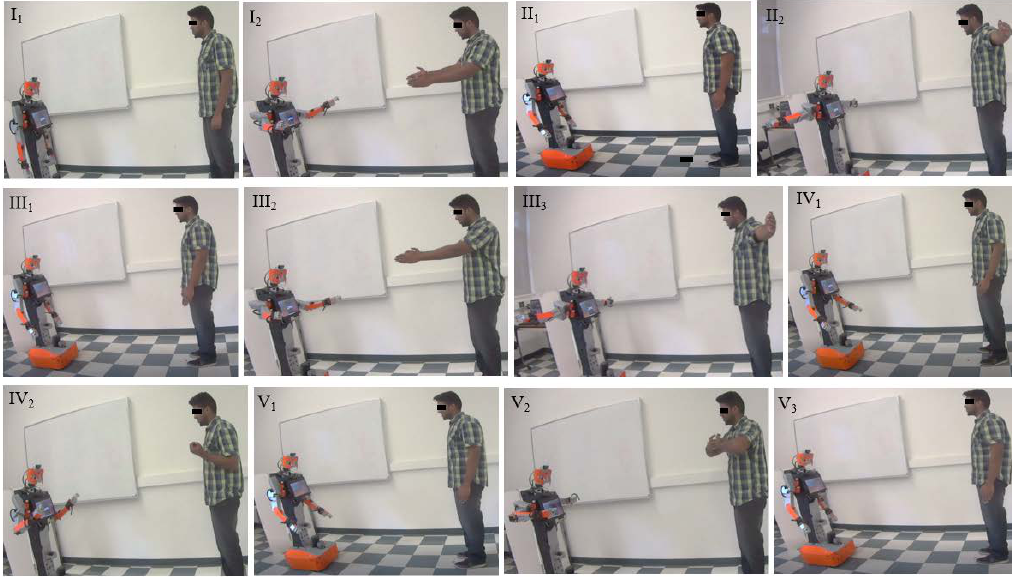
Figure 10. Video frame sequences when imitating human demonstrator motion using the imitation learning system. Five sets of motions include motion I ( I 1 – II 1 ), motion II ( II 1 – III 1 ), motion III ( III 1 – IV 1 ), motion IV ( IV 1 – V 1 ), and motion V ( V 1 – V 3 ).